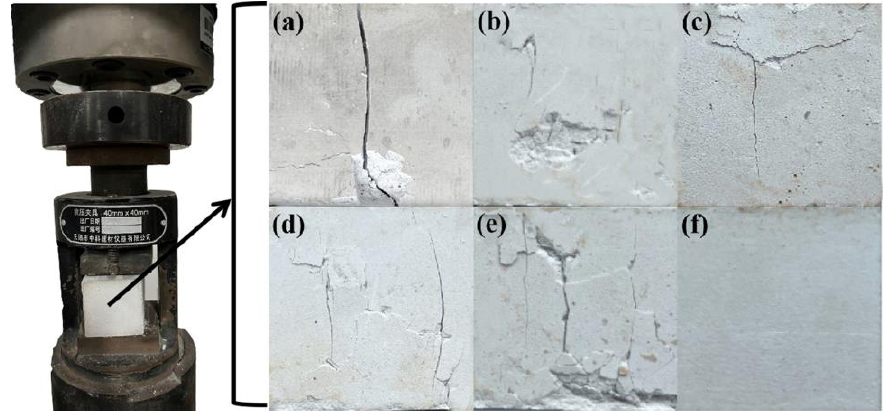
Figure 15. The failure testing process of the compressive strength. ( a ) PBGC-NWF; ( b ) PBGC-UWF; ( c ) PBGC-MWF1; ( d )PBGC-MWF2; ( e ) PBGC-MWF3; ( f ) PBGC-MWF4.